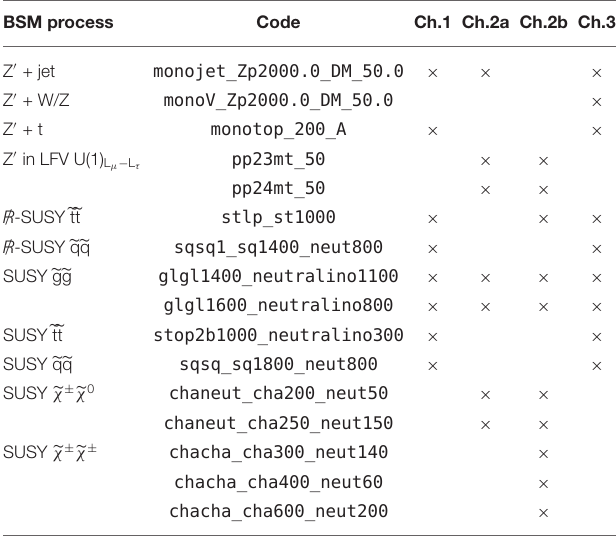
TABLE 2 | BSM processes contributing to the signal dataset in each channel. BSM